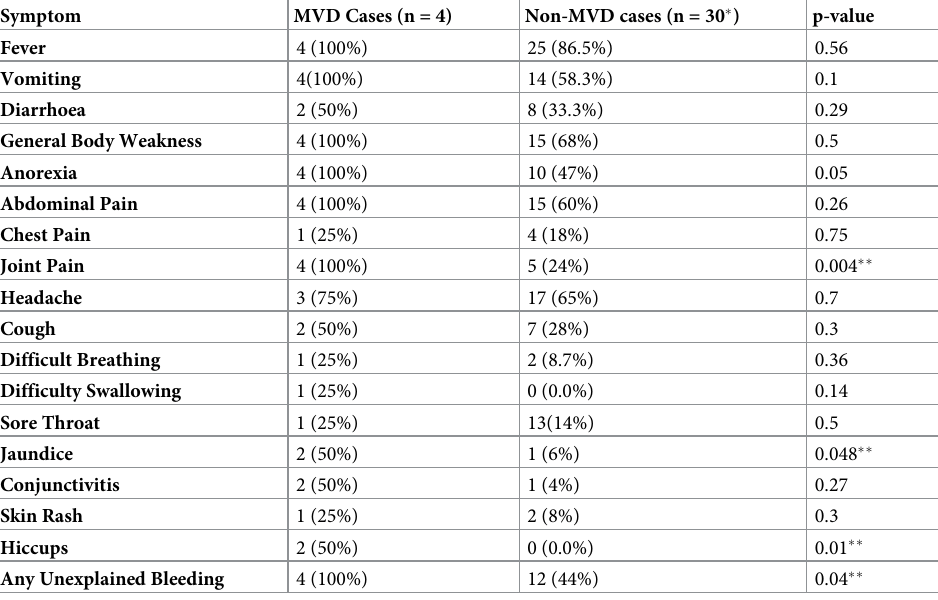
Table 1. Clinical symptoms of confirmed and probable cases compared to suspect cases that tested negative for Marburg virus.